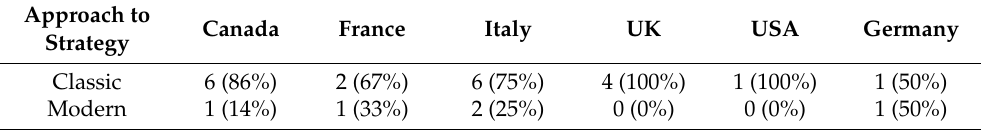
Table 10. Classic and modern approach to strategy by country—research results.